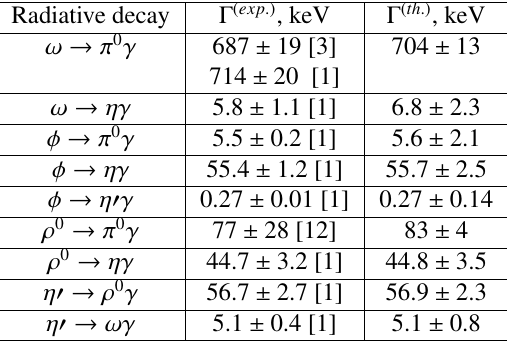
Table 2. Comparing experimental Γ ( exp . ) and theoretical values Γ ( th . ) for V ( P ) → P ( V ) γ decay